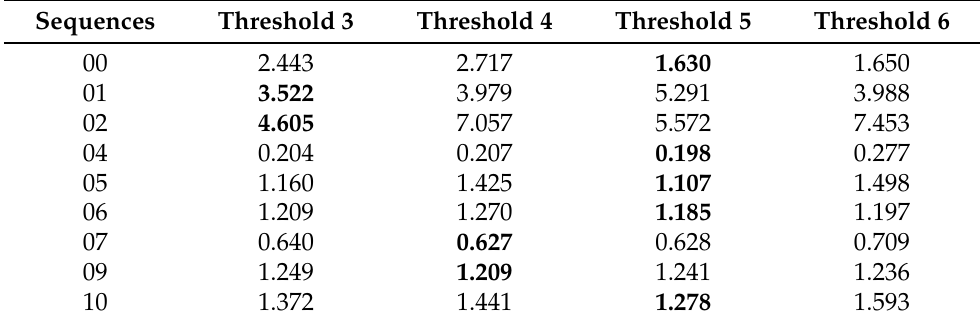
Table 5. Absolute trajectory error in our system using different present dynamic object thresholds in the adaptive feature point selector, The best results are bolded.